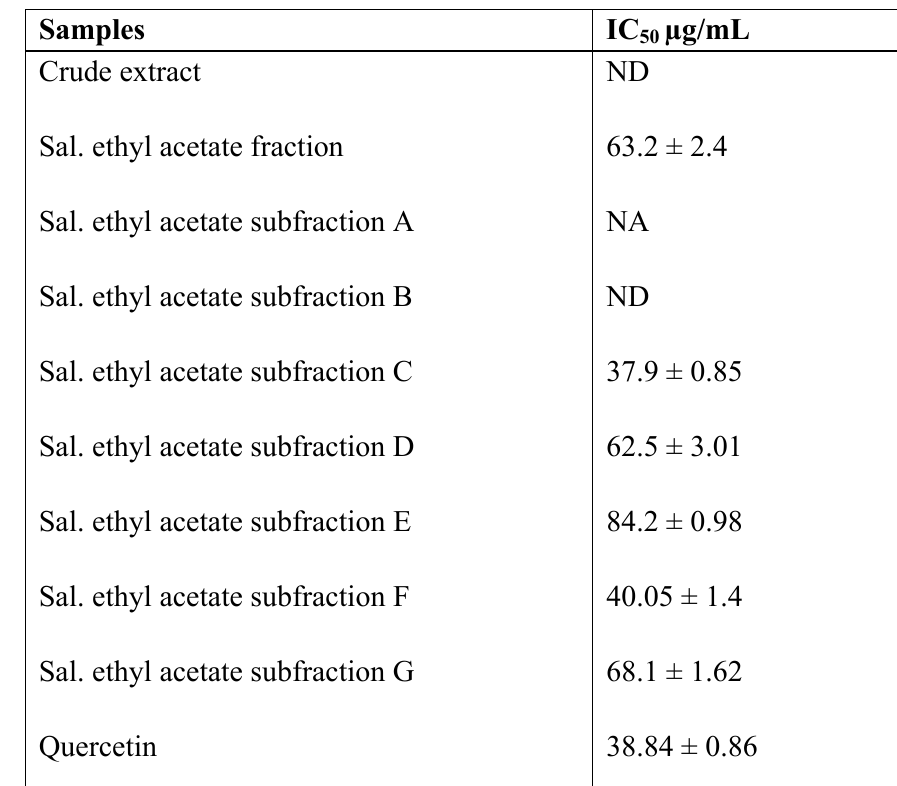
of Salvia mirzayanii subfractions compared with quercetin as Table 2: IC 50